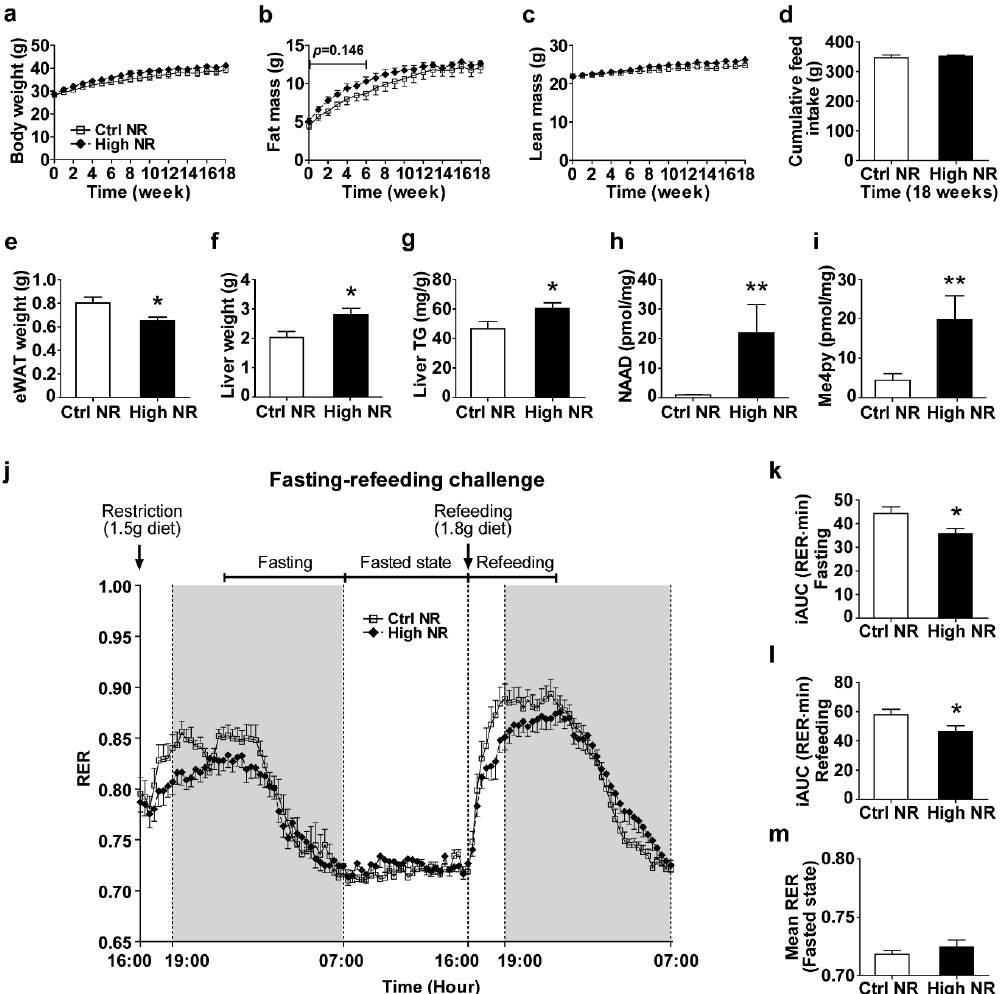
Figure 1. A high dose of nicotinamide riboside (NR) reduces metabolic flexibility and epididymal white adipose tissue (eWAT) weight. Mice were on obesogenic diets containing either 30 mg vitamin B3 (nicotinamide riboside, NR) per kg diet (control NR) or 9000 mg per kg diet (high NR) for 18 weeks. Body weight ( a ), fat mass ( b ), lean mass ( c ), cumulative feed intake ( d ). Fresh tissue weight of eWAT ( e ) and liver ( f ). Liver triglyceride (TG) content was determined and expressed per gram of tissue ( g ). Biomarkers for NR exposure effects are represented by the metabolites nicotinic acid adenine dinucleotide (NAAD) ( h ) and Me4py ( i ) in the liver. Levels are in pmol per mg frozen pulverized tissue. Fasting–refeeding challenge ( j ): restriction with 1.5 gram of diet at 16:00 h, fasting (from 22:00 h to 7:00 h), fasted (from 7:00 h to 16:00 h), refeeding with 1.8 gram of diet at next 16:00 h, refeeding (from 16:00h to 23:00 h) periods. Shaded areas indicate the dark, active periods. The incremental areas under the curve (iAUC) of the respiratory exchange ratio (RER) during fasting ( k ) and during refeeding ( l ) were analyzed to represent metabolic flexibility. The mean RER of the fasted state ( m ). Control NR: open square with solid line or white bar; high NR: closed diamond with black dashed line or black bar. Data are analyzed using either two-way repeated measures ANOVA followed by Bonferroni post-hoc analysis (a-c, and j) or Student’s t -test (d-i, k-m), and presented as mean ± SEM ( n = 11–12 mice per treatment). * p < 0.05, ** p < 0.01.